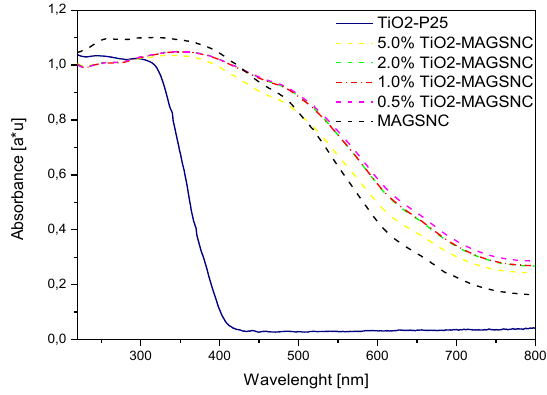
Figure 4. Diffuse reflectance (DR) Ultraviolet-Visible (UV-VIS) absorption spectra of different TiO 2 -MAGSNC photocatalysts. P25: pure commercial TiO 2 from Evonik Industries.